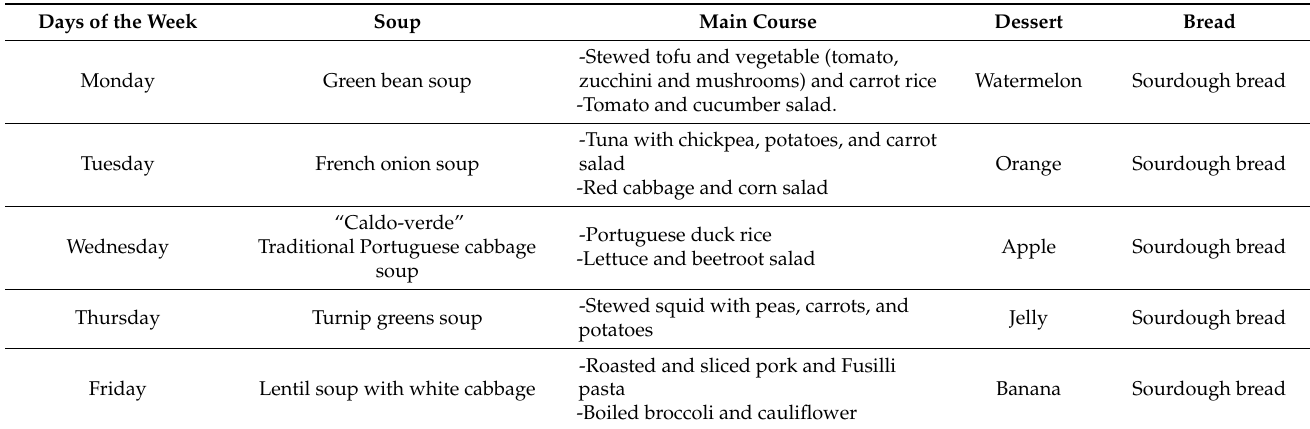
Table A1. Local menu of one